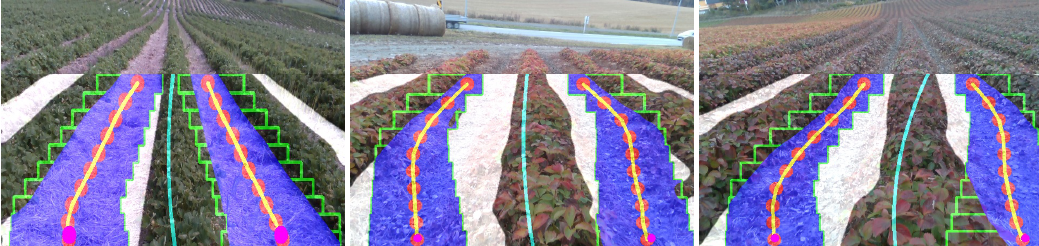
Figure 6. The above scenarios highlight the issue of the multi-ROI fitting using fixed margins ( m l , m r ) to the crop rows having different width. Courtesy: identified peaks (pink), rectangular boxes (green) indicates the ROIs and the chosen label as label points (blue) within